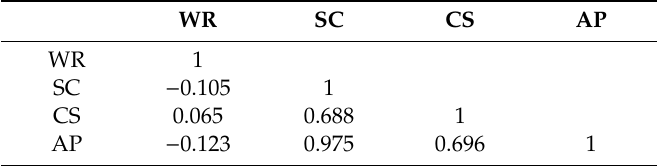
Figure 14. Trade-o ff s and synergies among the considered ESs at grid scaled level: ( A ) air purification vs. soil conservation, ( B ) air purification vs. carbon sequestration, ( C ) carbon sequestration vs. soil conservation, ( D ) water retention vs. soil conservation, ( E ) water retention vs. carbon sequestration, ( F ) water retention vs. air purification. Table 4. Pearson correlation coe ffi cient of the regulation of ecosystem